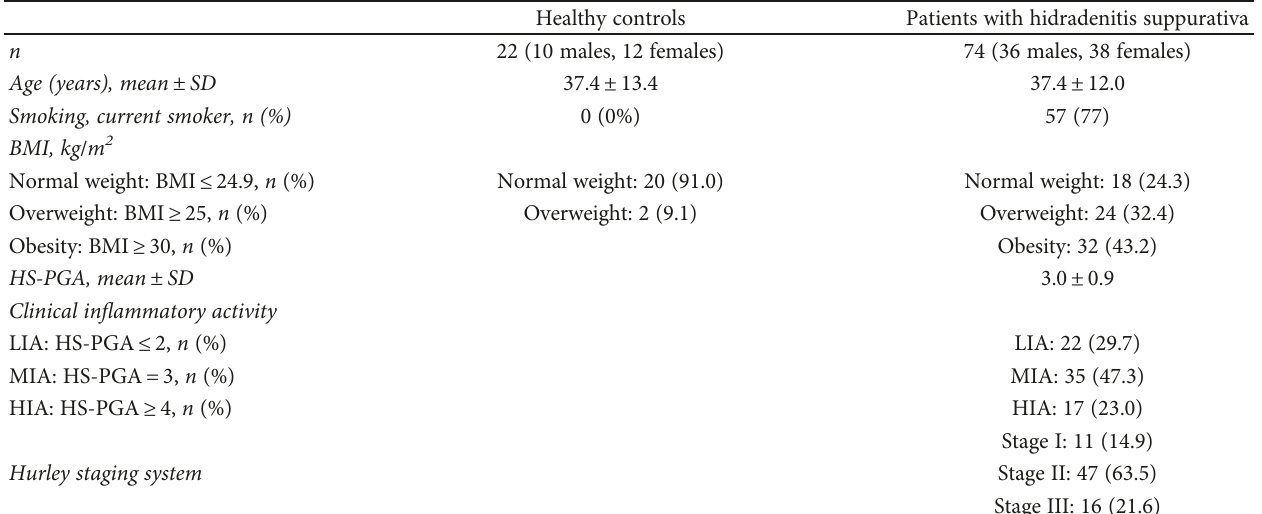
Table 1: Demographics of healthy controls and patients with hidradenitis